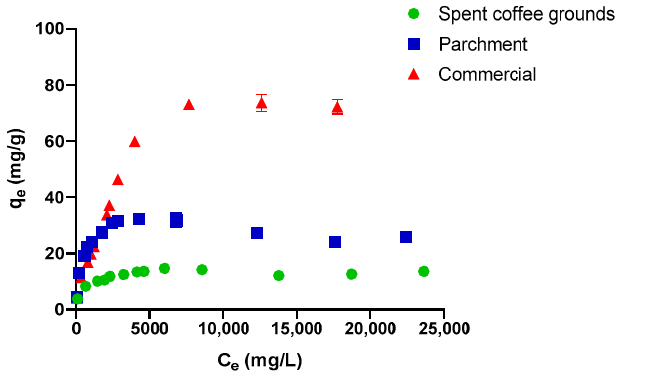
Figure 5. Adsorption capacity (q e ) for lactic acid versus lactic acid concentration at equilibrium in liquid phase (C e ) for spent coffee grounds, parchment, and commercial activated carbons, without pH corrections, adsorbent dose 10% ( w / v ) and 4 h contact time at room temperature.